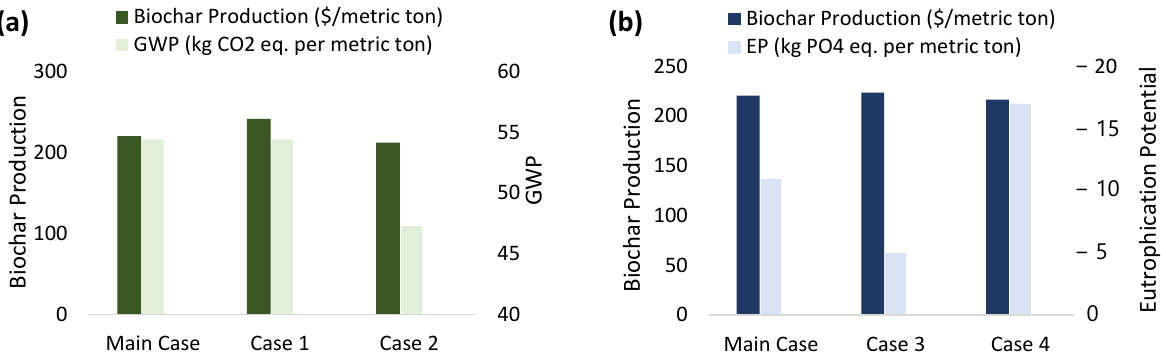
Figure 8. Sensitivity analysis: ( a ) effects of biomaterial production rate; ( b ) effects of phosphorus removal capacity on environmental and economic impact; (base case) two biorefineries and adsorption rate 100 µg/g; (case 1) one biorefinery; (case 2) two biorefineries; (case 3) adsorption rate 50 µg/g; (case 4) adsorption rate 150 µg/g.